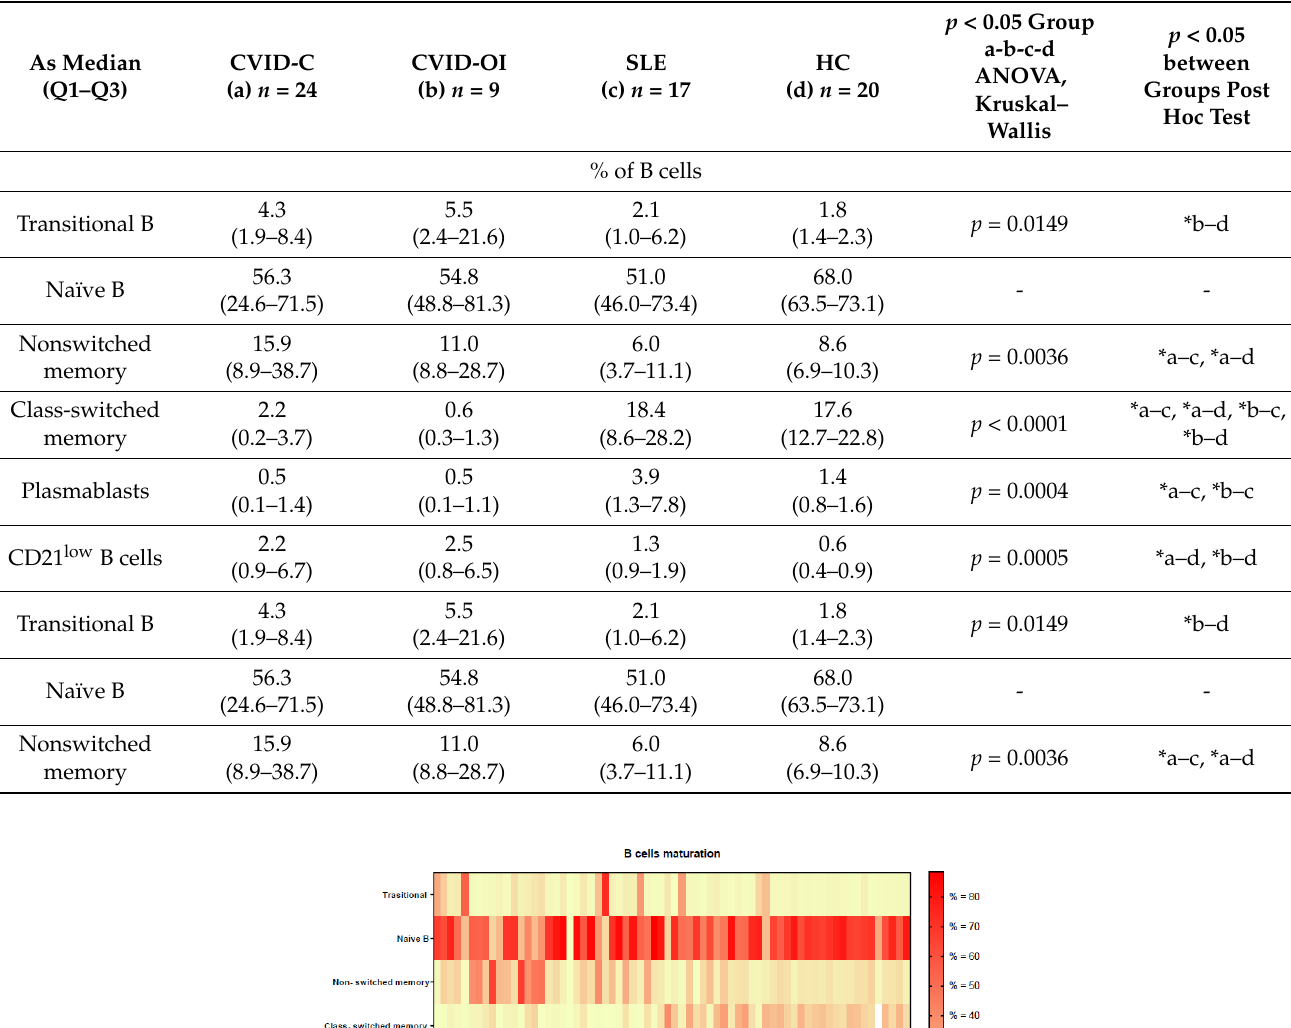
Table 3. Differences in the proportions of B lymphocyte maturation between (a) the CVID with complicated phenotype (CVID-C) group, (b) CVID phenotype limited to only infections (CVID-OI group), (c) patients with systemic lupus erythe- matosus (SLE), and (d) healthy controls (HCs). Data expressed as median (Q1–Q3). * p < 0.05. ANOVA: analysis of variance, Post Hoc: post hoc analysis tests.